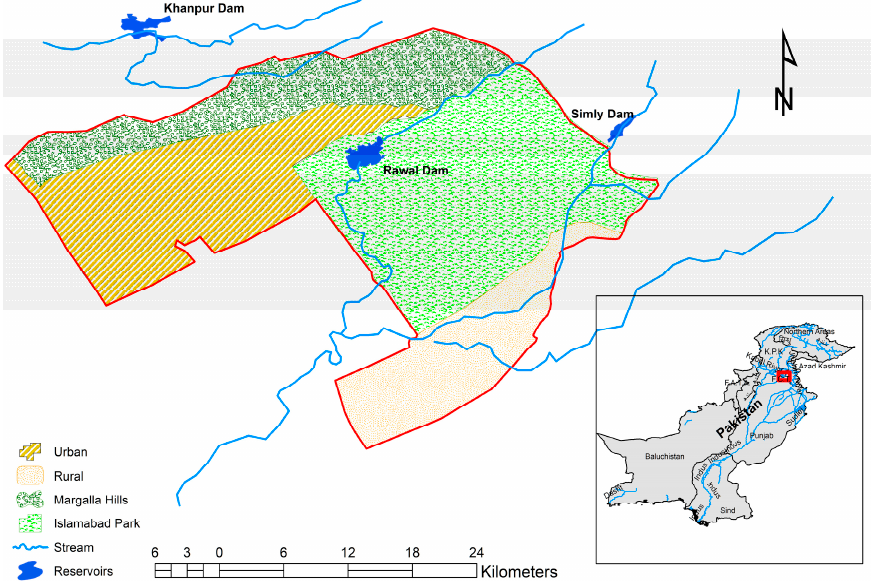
Figure 2. Map of Islamabad (Inset: Pakistan).